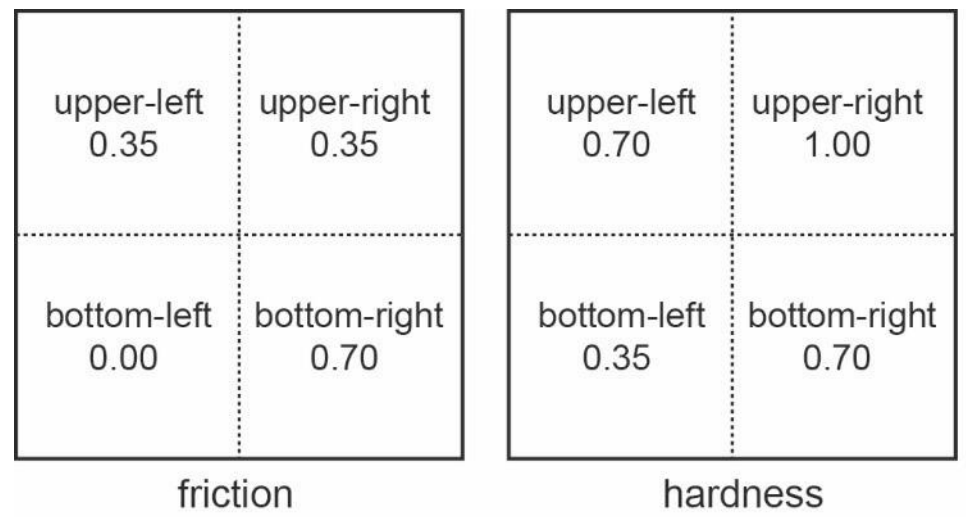
Figure 2. The two variables—friction and hardness—are represented in the two tests. Each test is divided into four virtual surfaces. There is a specific value for each surface, but two out of the four surfaces had the same values.